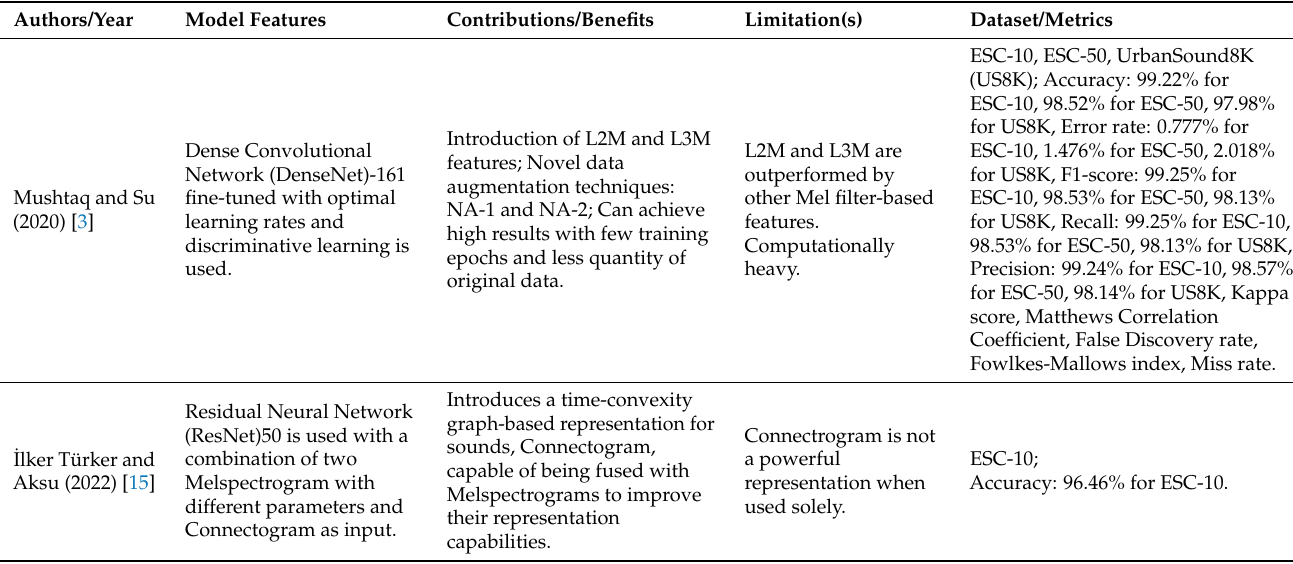
Table 6. Resume of the research articles found on audio segmentation that introduce new feature extraction techniques.